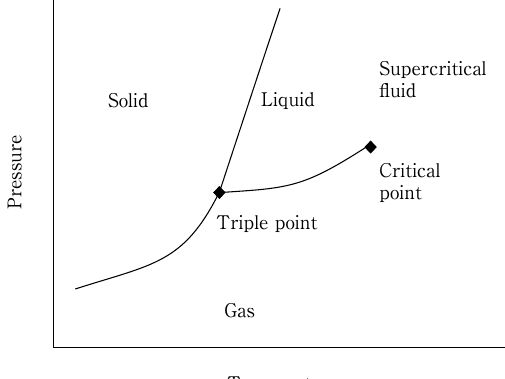
Fig. 4 Phase diagram of a pure